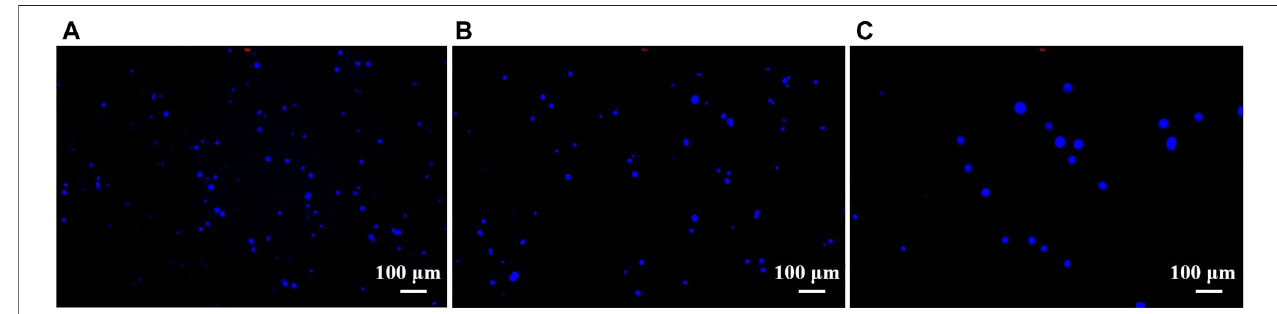
Frontiers in Bioengineering and Biotechnology |